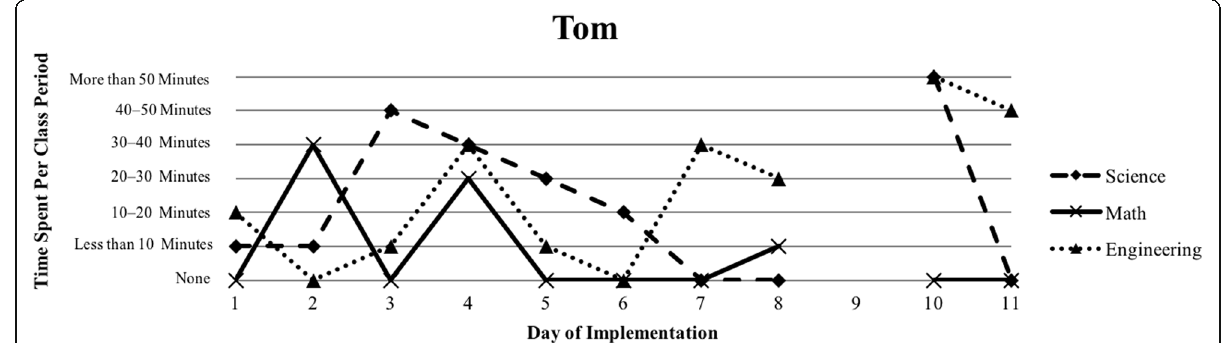
Fig. 7 Tom ’ s implementation of the Particle Nature of Matter in his 6th grade science